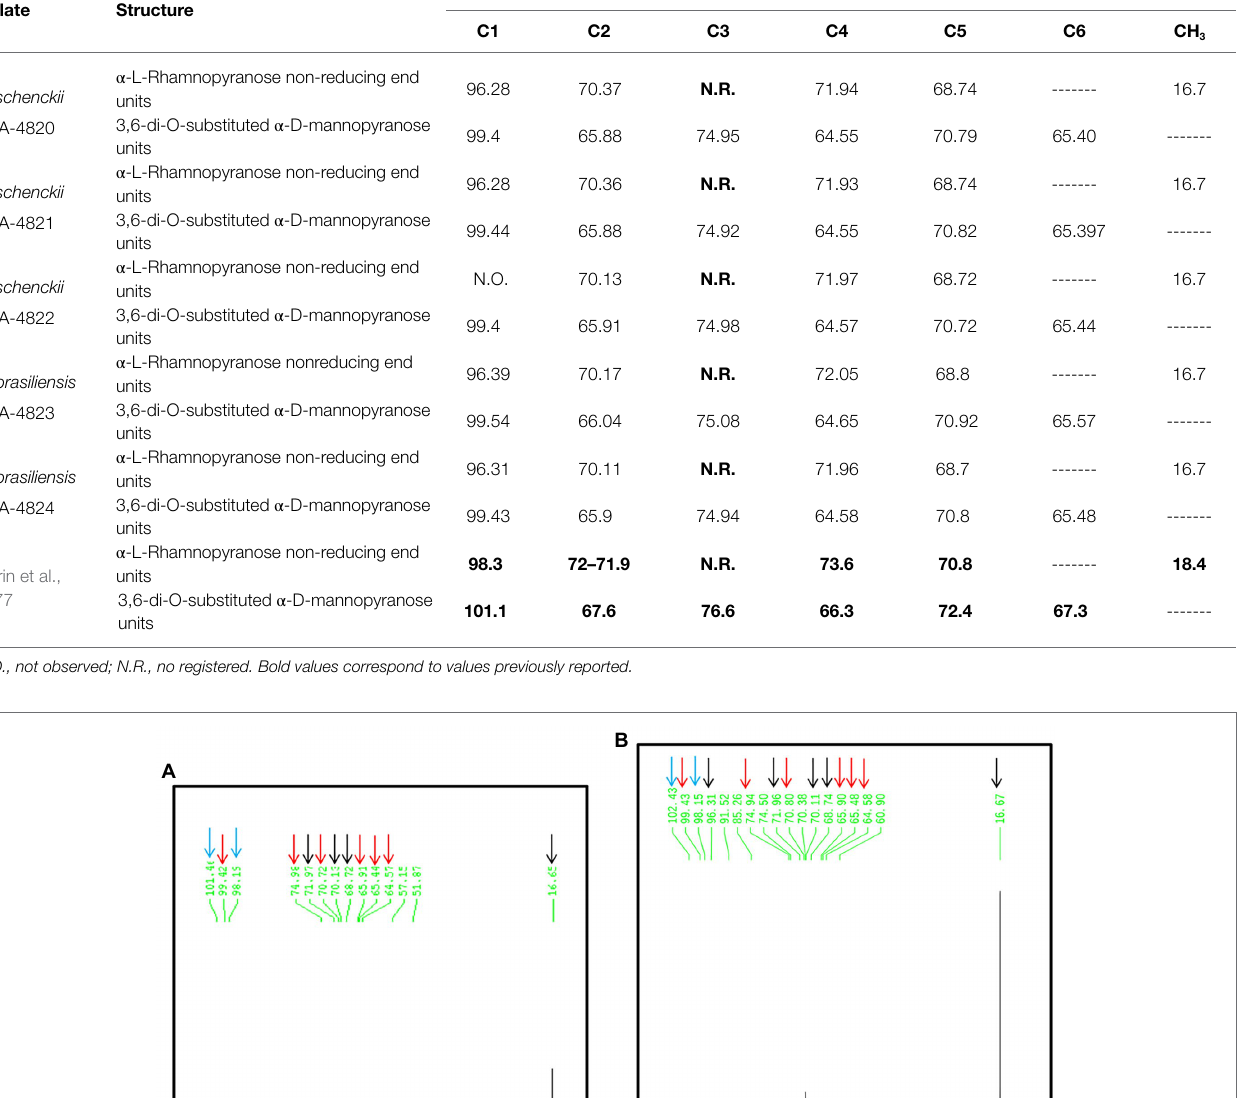
Isolate Structure